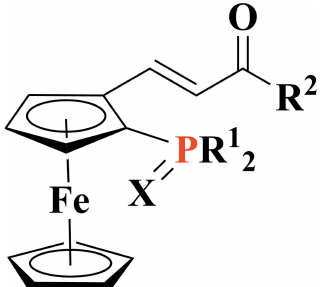
Figure 4 The model used for the CCDC